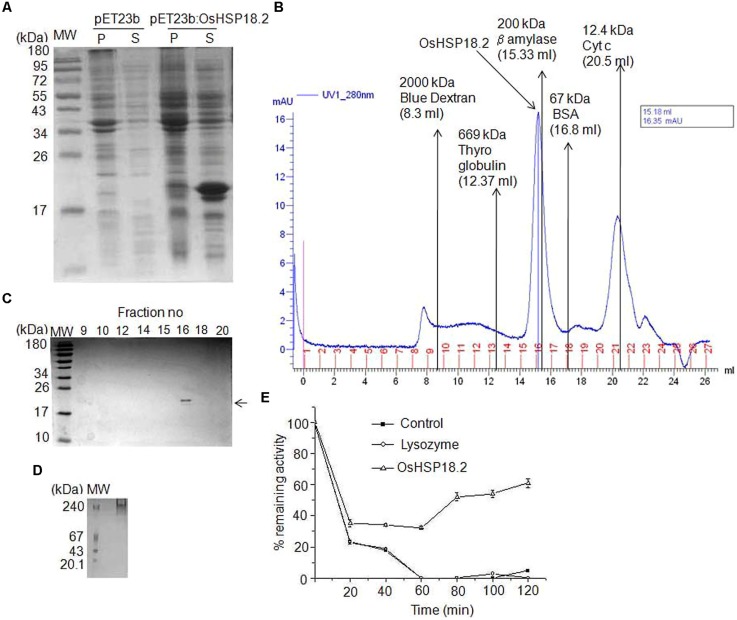
Characterization of recombinant OsHSP18.2. (A) Bacterial overexpression of OsHSP18.2 in Escherichia coli. Proteins were separated on a 15% SDS-PAGE gel. pET23b empty vector transformed cells were used as a control. Pellet (P) and Supernatant (S) were run for control and OsHSP18.2 transformed cells along with the molecular weight marker. (B) Size exclusion chromatography on Superose 6 column revealed the homooligomeric nature of OsHSP18.2. Purified protein and appropriate molecular weight markers were run and their elution time (Ve) to void volume (Vo) ratio (Ve/Vo) was plotted against their molecular weight in log scale and fitted in an exponential function where y = 512304e-4.306x. Approximate molecular weight of OsHSP18.2 was calculated from the above equation as ∼202 kDa which reflects dodecameric conformation. (C) Gel filtration fractions as run on 15% SDS-PAGE show a single band of OsHSP18.2 in fraction number 16 corresponding to the gel filtration peak. (D) Five percent native polyacrylamide gel shows a protein band of OsHSP18.2 across the 240 kDa marker band. (E) OsHSP18.2 prevents irreversible thermal inactivation of CS at 38°C. CS was incubated without HSP (—■—), with lysozyme (—○—) and with OsHSP18.2 (—Δ—) at 38°C for 60 min and then shifted to 22°C for refolding. CS enzyme activity was assayed at the mentioned time points. Values are the mean ± SE of three independent experiments.